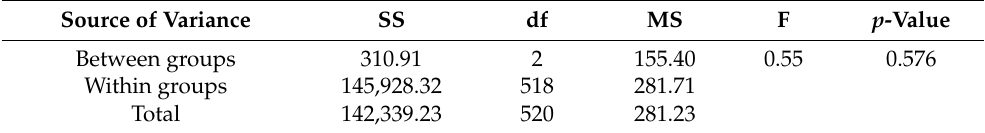
Table 3. One-way ANOVA on SUS